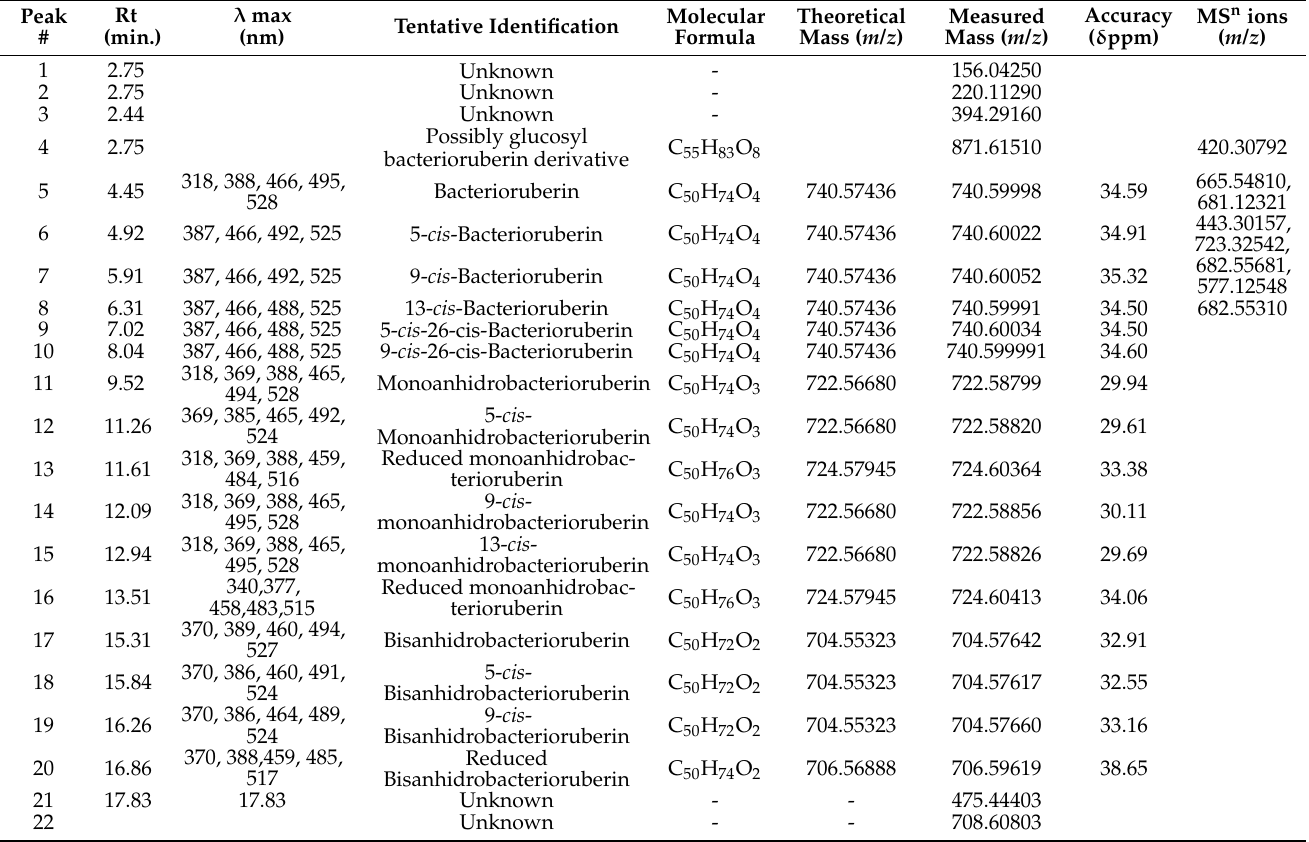
Table 1. UHPLC-Q-OT-MS/MS data of haloarchaea strains: Te Se-85, Te Se-86, ALT-23, TeSe-41, TeSe-51 and TeSe-89. Peak numbers refer to Figure